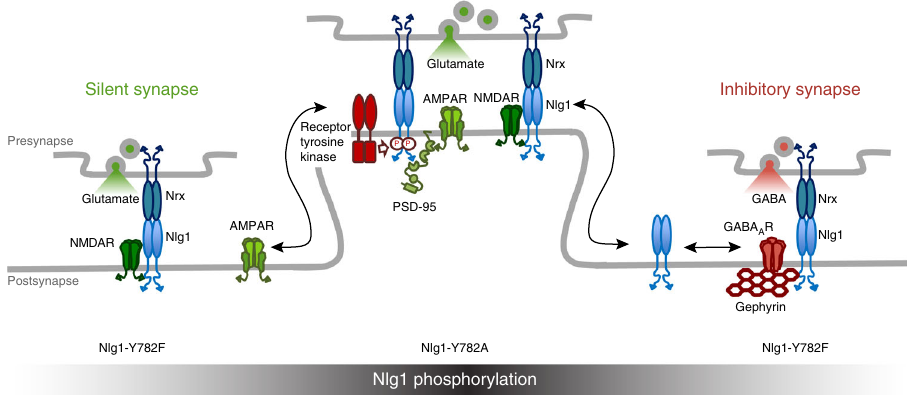
Fig. 9 Working model for the role of Nlg1 tyrosine phosphorylation in synapse differentiation and potentiation. Phosphorylated Nlg1 (mimicked by Nlg1- Y782A) preferentially recruits PSD-95 and AMPARs and favors dendritic spines. In contrast, non-phosphorylated Nlg1 (mimicked by Nlg1-Y782F) diffuses out of dendritic spines and interacts preferentially with gephyrin, thus preventing PSD-95 and AMPAR recruitment and resulting in silent synapses. NMDARs are recruited independently of mutations in the Nlg1 intracellular domain, consistent with a direct extracellular coupling to Nlg1. A fraction of Nlg1-Y782F associates with gephyrin scaffolds and GABA A receptors to make inhibitory